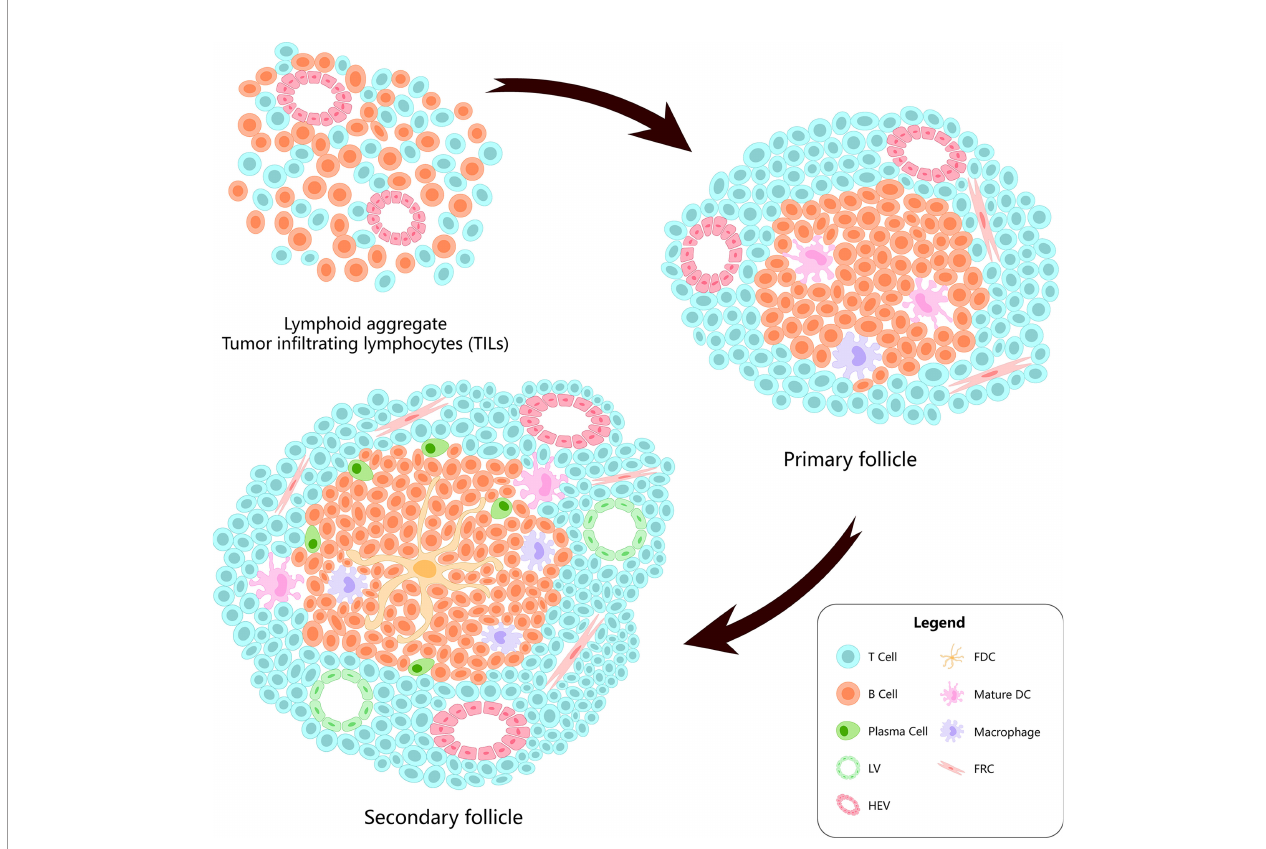
FIGURE 1 | The evolution of the tertiary lymphatic